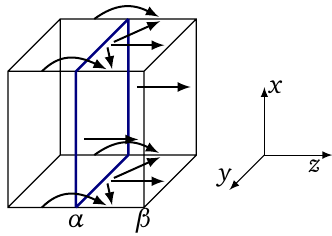
Figure 7: The finite depth local unitary to remove an x y toric code leaf (the α plane highlighted in blue) from an X-cube model. The arrows denote CNOT gates going from the control qubit to the target qubit. We should apply this process everywhere on the α plane.